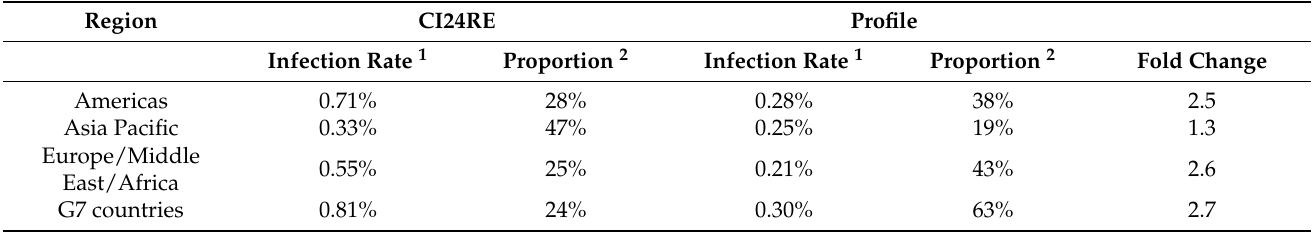
Table 2. Percentage of infections leading to explant by geographical region